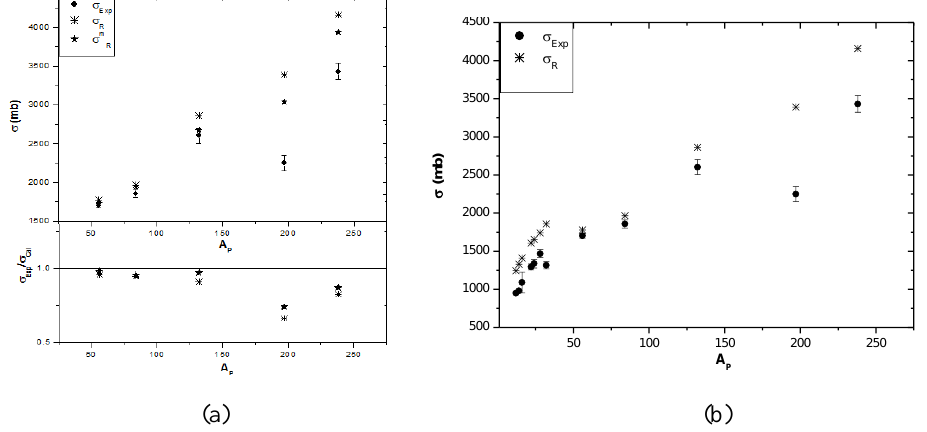
Fig.1. (a) The reaction cross section calculated with and without in-medium effect and corresponding experimental data for projectiles 56 Fe 26 , 84 Kr 36 , 132 Xe 54 , 197 Au 79 and 238 U 92 at around 1 GeV/n. (b) Calculated reaction cross sections σ R values for different projectiles